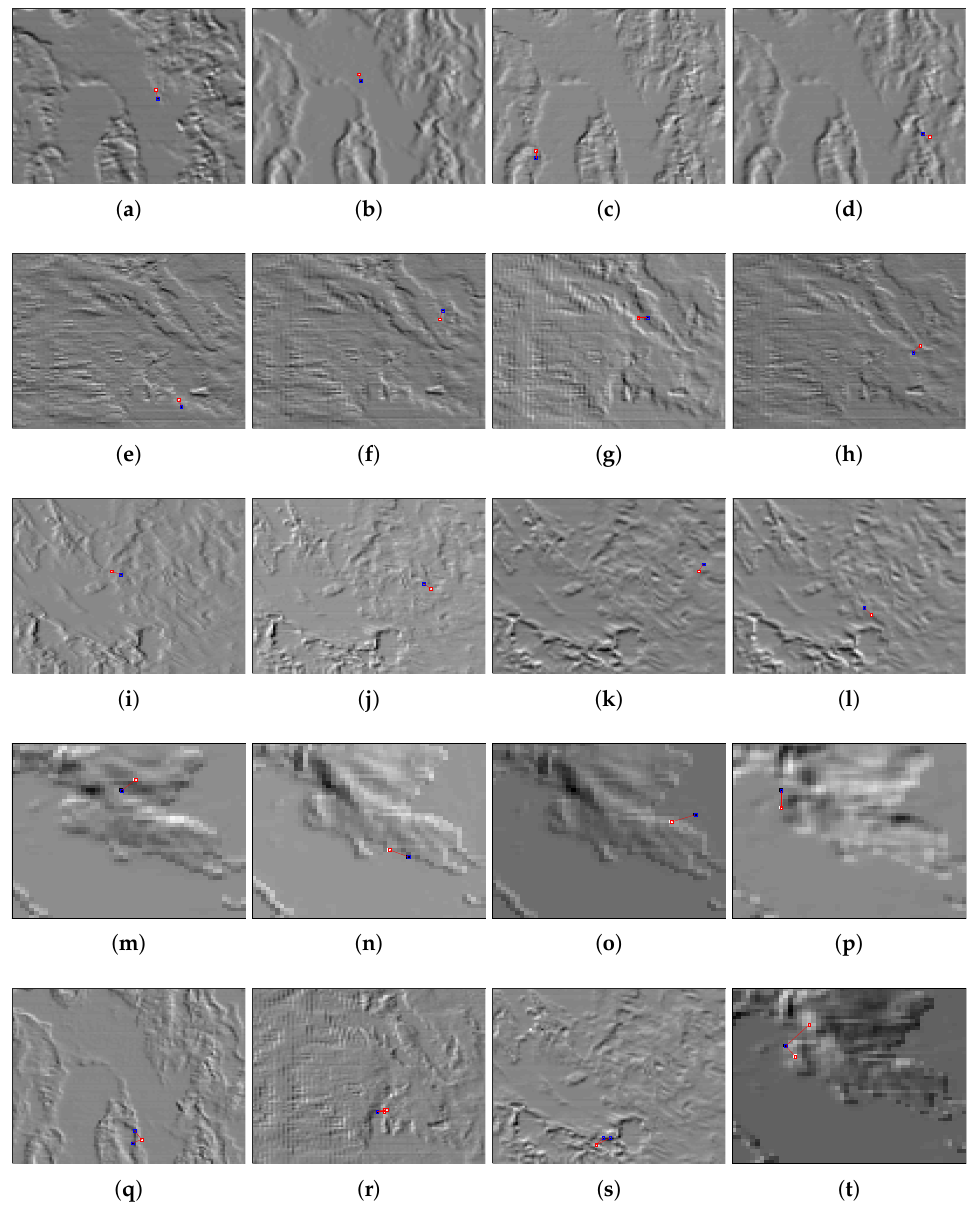
Figure 10. Thedata association results with targets in different positions in various complex back- grounds. ( a – p ) target pairs were associated correctly, ( q – t ) one target was associated with two or more